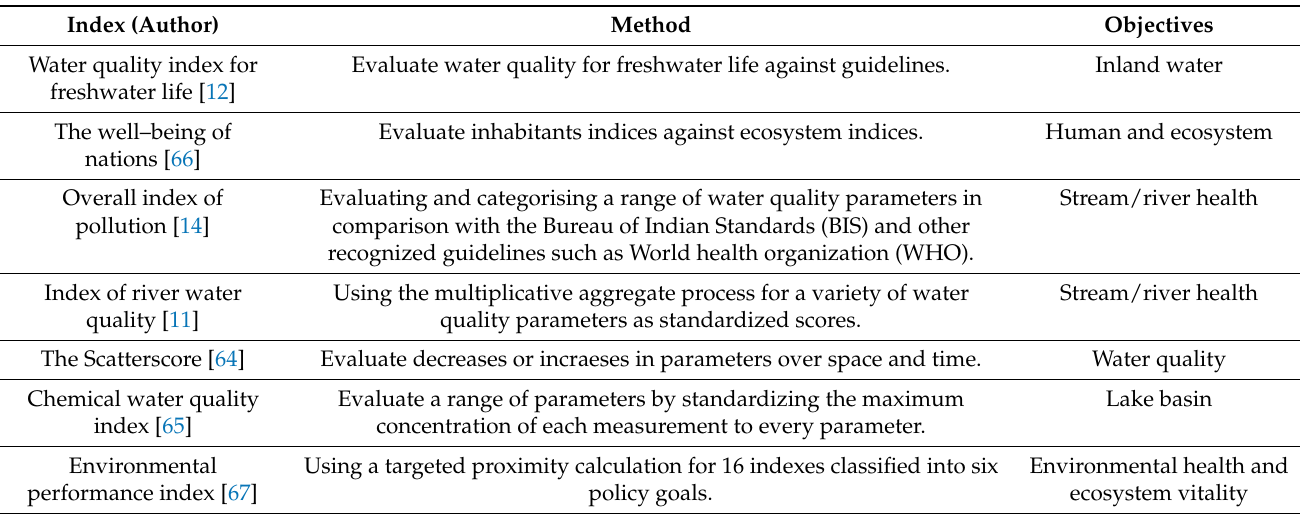
Table 1. The development of WQI and its compariosn based on national or regional